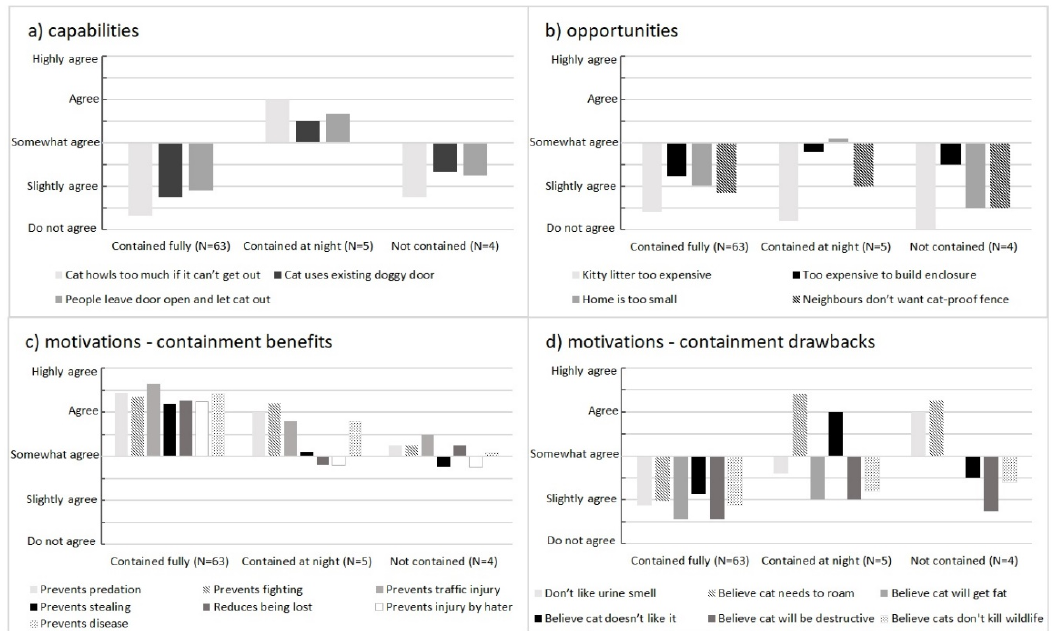
Figure 3. Average agreement scores (5 = highly agree, 4 = agree, 3 = somewhat agree, 2 = slightly agree, 1 = do not agree) to the 20 identified driver and barrier factors ( a ) 3 capabilities, ( b ) 4 opportunities, ( c ) 7 positive motivations, and ( d ) 6 negative motivations) for participants keeping their cat fully contained (N = 63), contained at night only (N = 5) and not contained (N = 4). Refer to Table 1 for the list and description of these factors. Table 3. Summary of demographic variables across the three containment profiles.